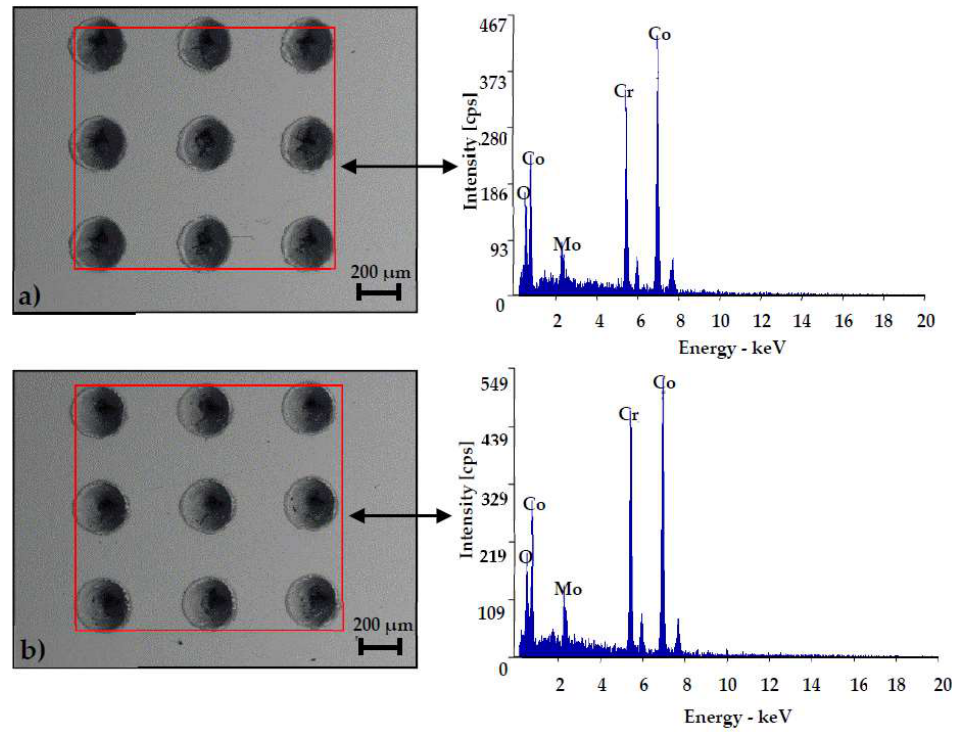
Figure 5. EDS elemental mapping obtained by BES-SEM over the dimples of the textured ASTM F-1537 cobalt alloy. The image corresponds to the dimples created with a laser power of 70%, and three times process repetition, at a repetition rate of: ( a ) 140 kHz, and ( b ) 210 kHz.